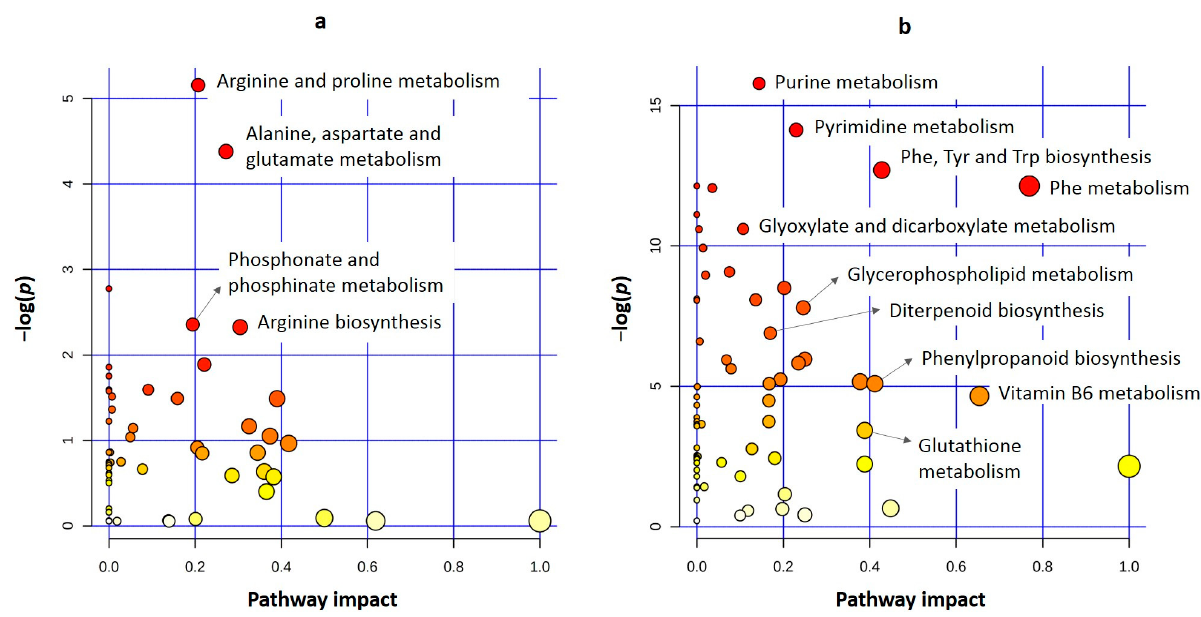
Figure 5. Metabolomics Pathway Analysis (MetPA) of rachis tissue from the resistant Fhb7E (HOM+) and susceptible (HOM − ) lines at 4 dpi after water ( mock ) or Fg treatment: ( a ) mock -HOM+ vs. mock - HOM − , and ( b ) Fg -HOM+ vs. Fg -HOM − comparisons. All matched pathways are displayed as circles. The colour of each circle is based on p -values (darker colours indicate more significant changes of metabolites in the corresponding pathway), whereas the circle size corresponds to the pathway impact score. The most impacted pathways (high statistical significance scores) are annotated by their full name (Phe, phenylalanine; Tyr, tyrosine; Trp, tryptophan). As for the constitutive pathways, i.e., those independent of Fg inoculation, the HOM+ mock vs. HOM − mock comparison (Figure 5a) revealed significant alterations (FDR < 0.05; pathway impact values > 0.1) in two amino acid pathways: one of “Arginine and proline metabolism” (downregulated in HOM+ vs. HOM − ), and the other of “Alanine, aspartate and glutamate metabolism” (upregulated in HOM+ vs. HOM − ). This was in line with